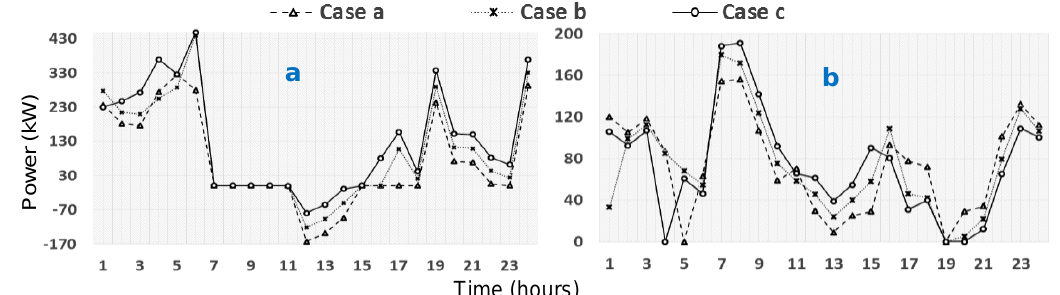
Figure 9. Collective power trading: ( a ) Internal trading; and ( b ) External trading.